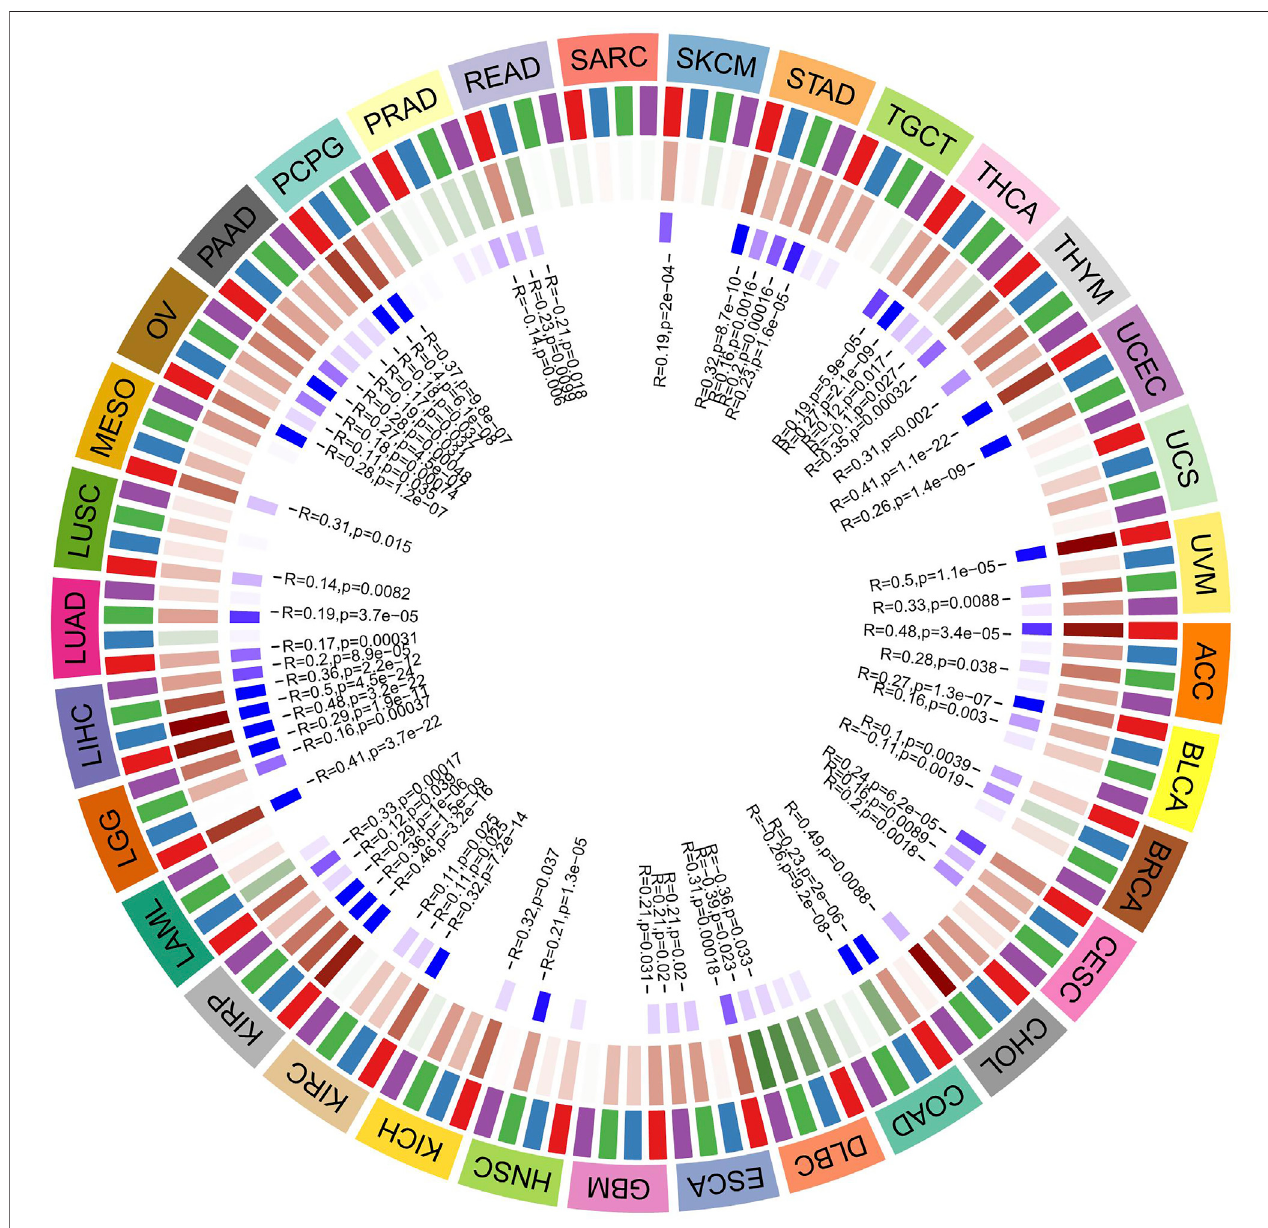
FIGURE6| Therelationshipbetween4methyltransferasesandtheexpressionlevelofATG101.Thedarkerthebluesquareintheinnercirclerepresentsthesmaller the p value of the corresponding tumor. The red square in the middle circle represents a positive correlation, and the green represents a negative correlation, and the darker the color, the higher the